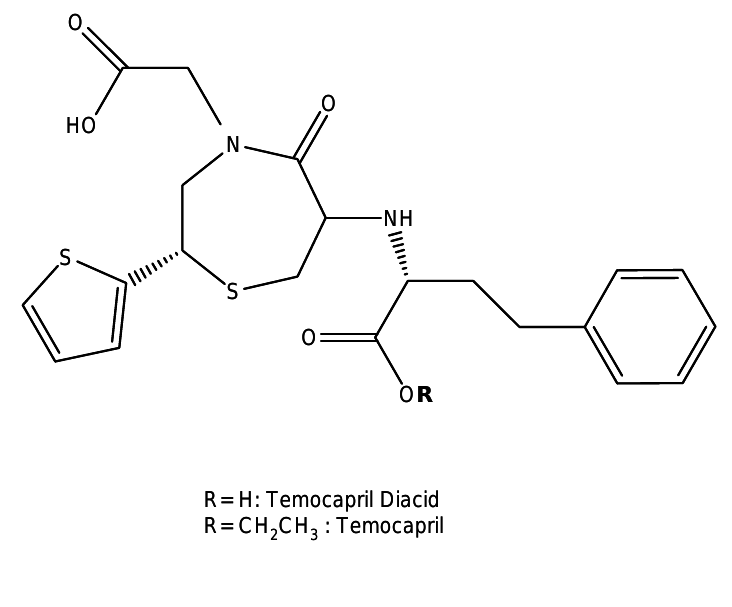
Figure 7. Chemical structure of temocapril diacid and temocapril